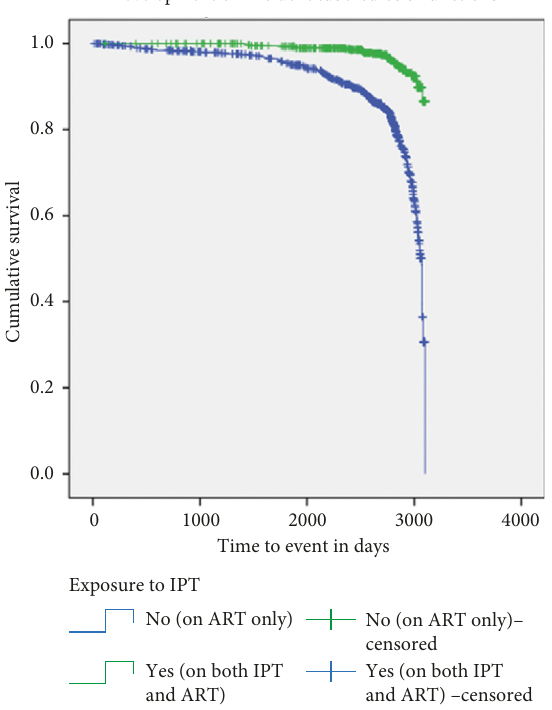
Figure 2: Kaplan–Meier for incidence of TB among patients living with HIV/AIDS taking IPTand ARTversus ARTalone in Northern Ethiopia,